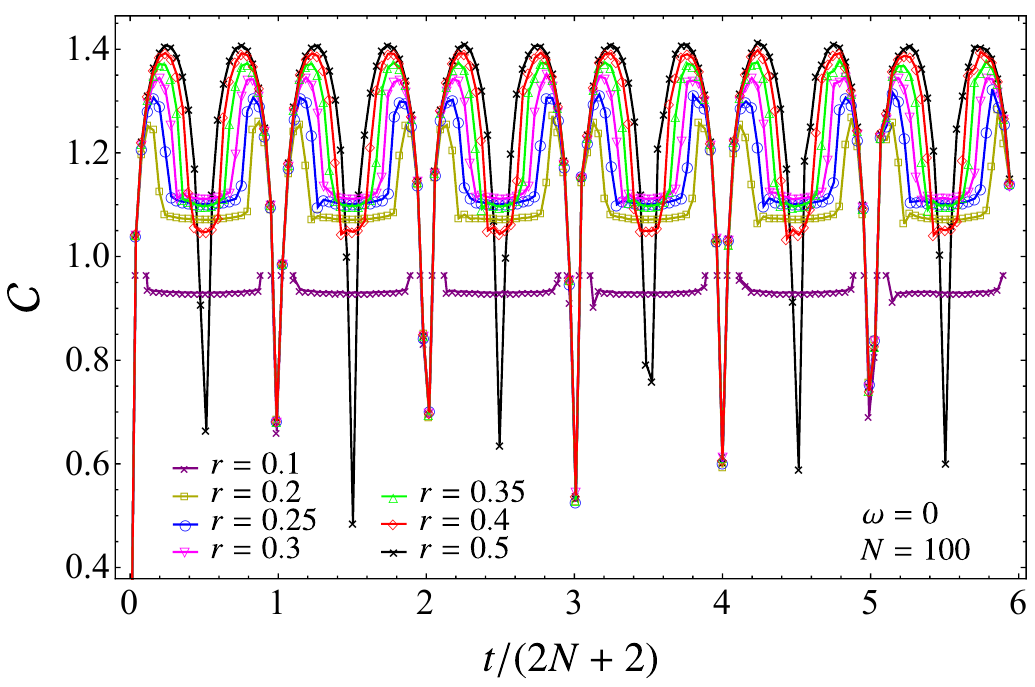
Figure 3 . Temporal evolution of the complexity C in (3.1) for the chain with N = 100 after a local quench with ω = 0 w.r.t. the initial state, for various positions of the joining point (see the top panel of figure